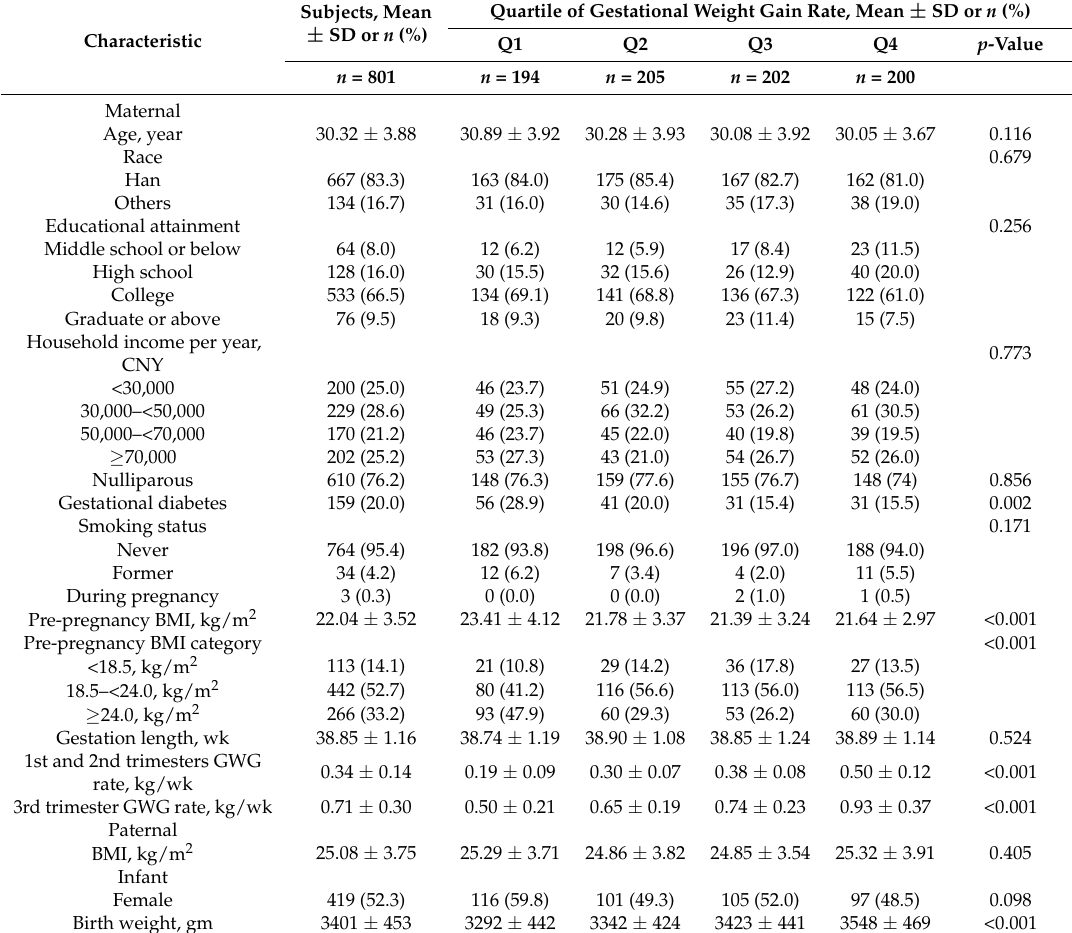
Table 1. Participants characteristics according to quartiles of total gestational weight gain rate among 801 mother–infant pairs in Born in Shenyang